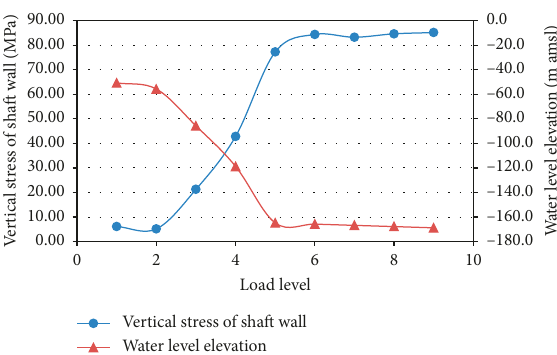
Figure 7: Variation of water level drainage and vertical stress of the shaft wall with load